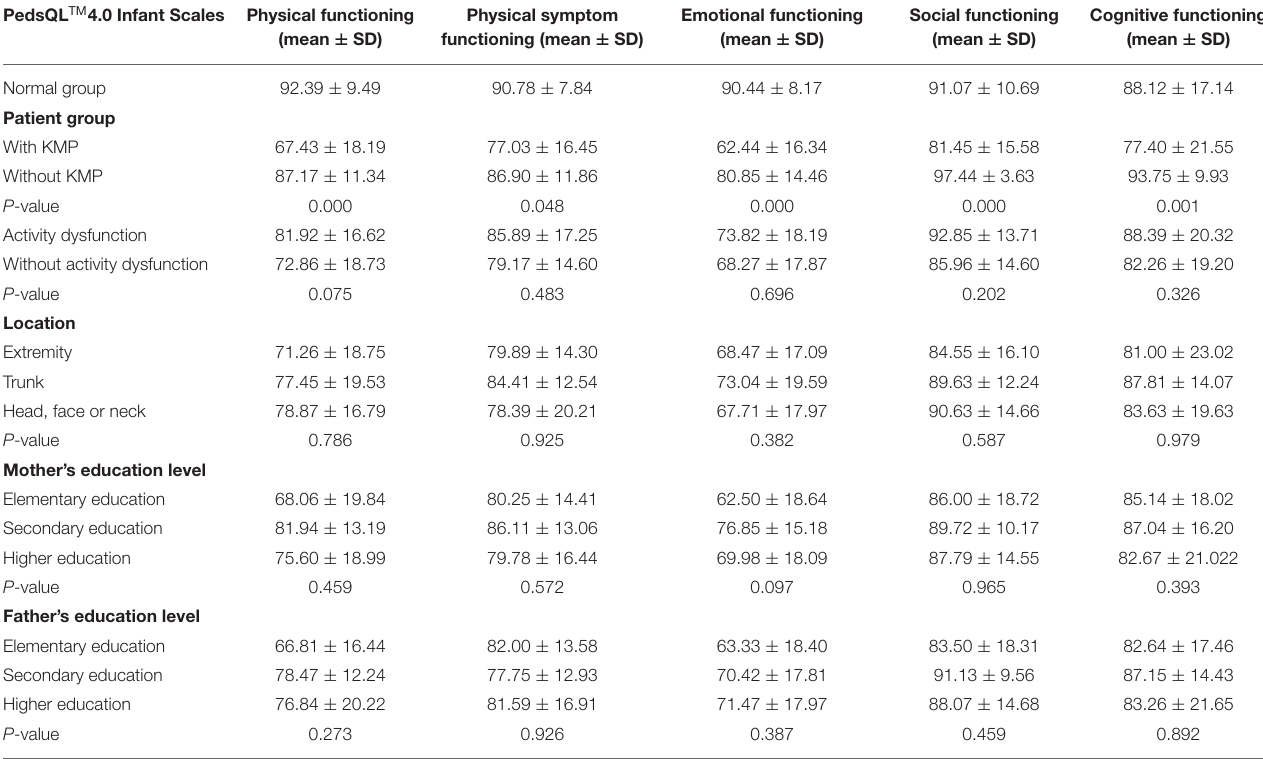
TABLE 6 | Analysis and score for each dimension of the PedsQL TM 4.0 Infant Scales (age ≤ 24